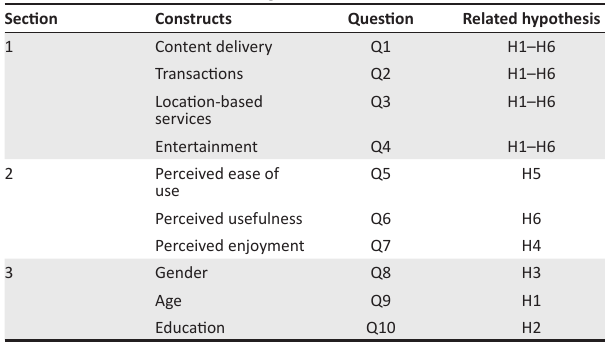
TABLE 1: Research instrument